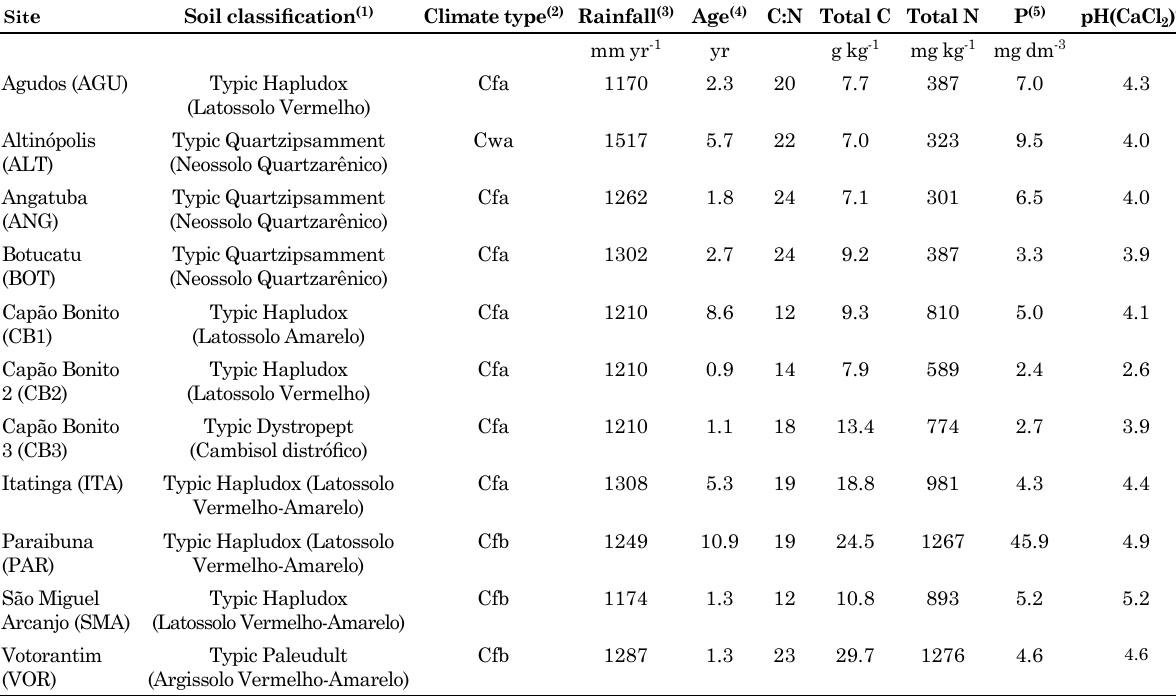
table 1. selected characteristics of the experimental sites measured in samples of the 0-20 cm layer sit